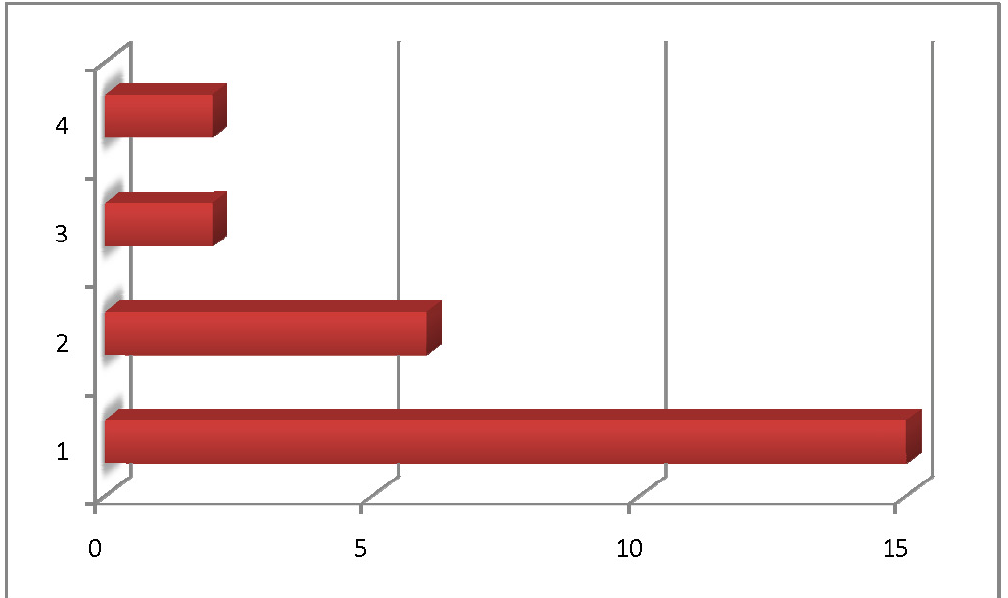
FIGURE 4 - Demonstrative graph of the number of pancreatics branches proceeding from the pancreatic tail (vertical axle) that drain into the lienal vein, and its frequency (horizontal